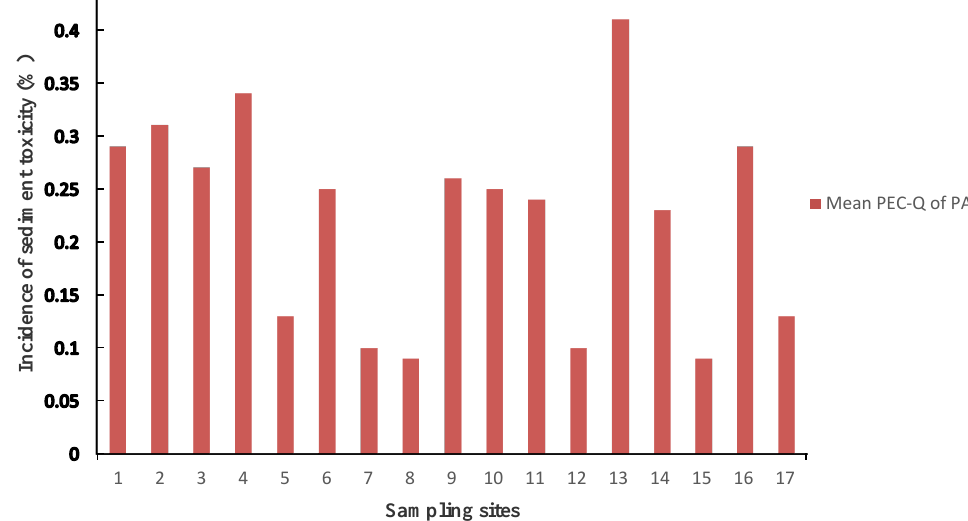
Figure 2. Distribution of the toxicity trend of DEHP and DBP mixture in U-Tapao canal.